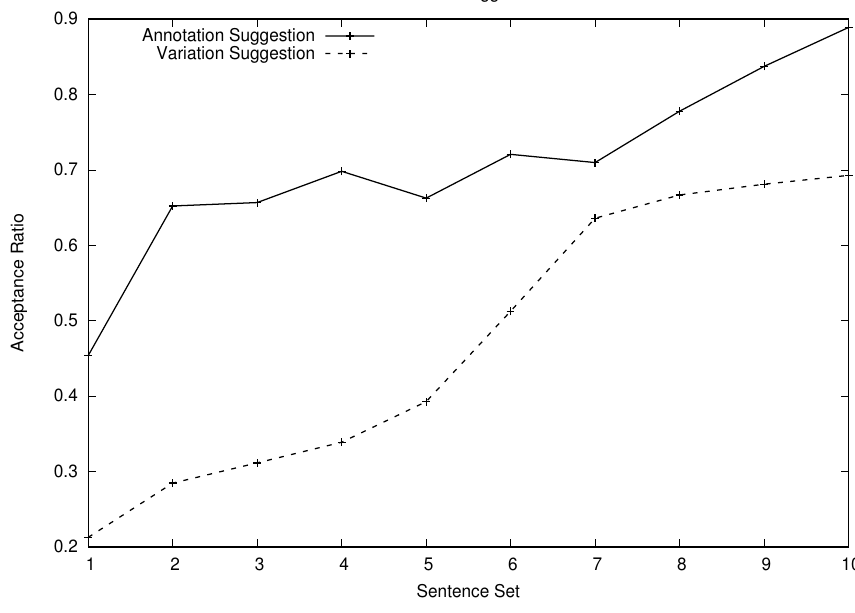
Figure 2. Curves for acceptance ratio of